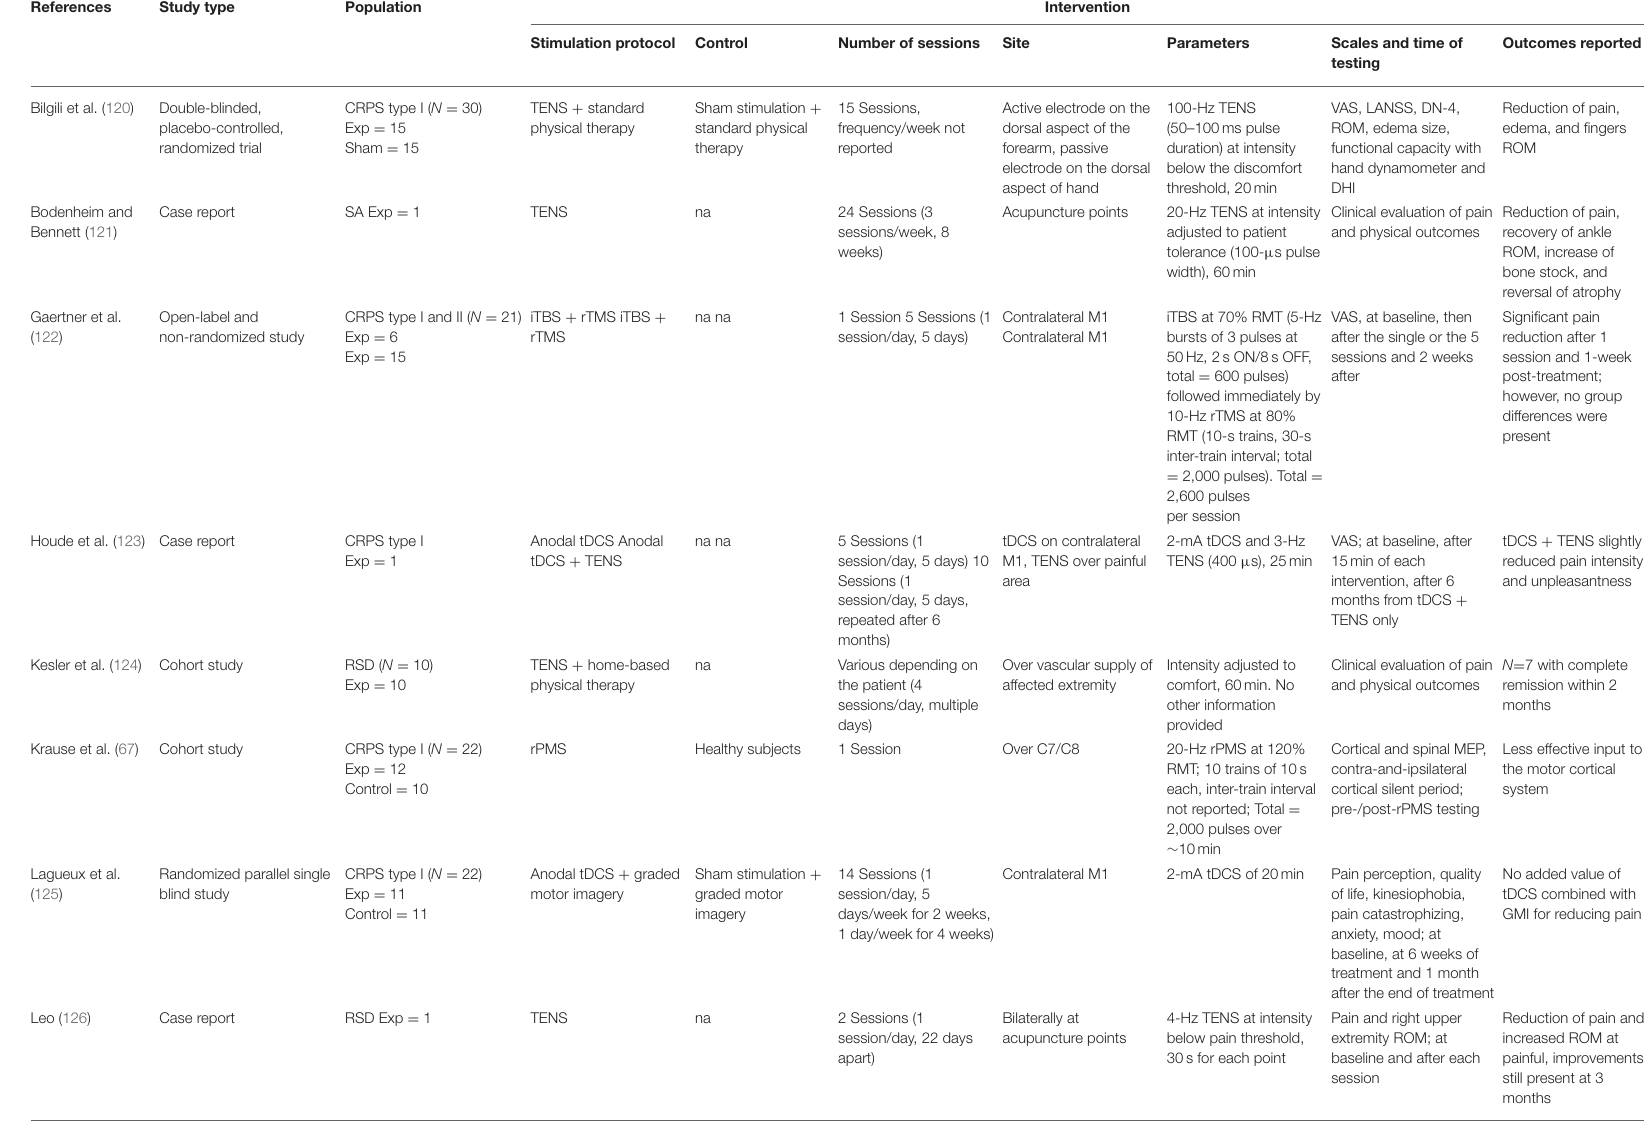
TABLE 3 | Studies with noninvasive neurostimulation in